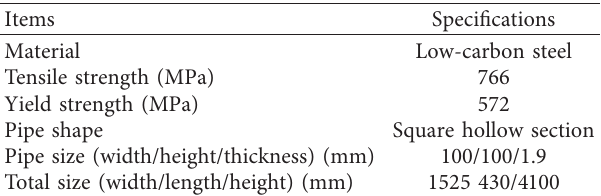
Table 2: Specifications of material of creep test rig.